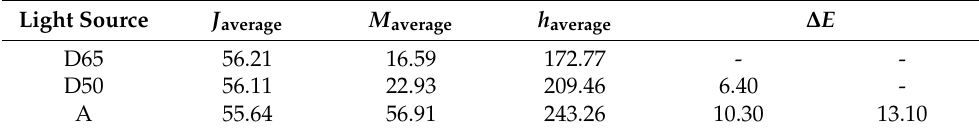
Table 6. Colour appearance attributes J , M , and h and colour difference under three light sources.